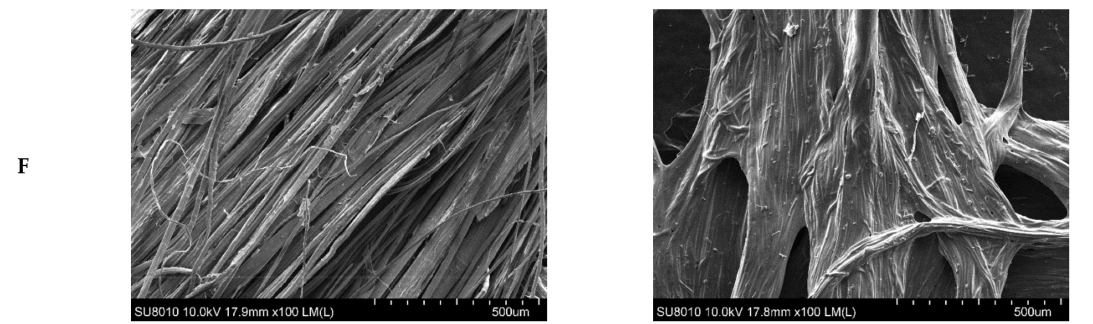
Figure 7. SEM images of A, G, C, B, and F fabrics before burning tests ( left column) and V-AGCBF laminates after the burning test ( right column).